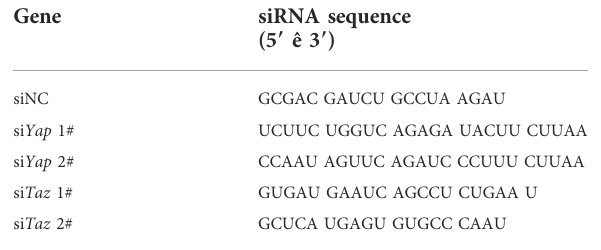
TABLE 2 siRNA sequences for targeting Yap and